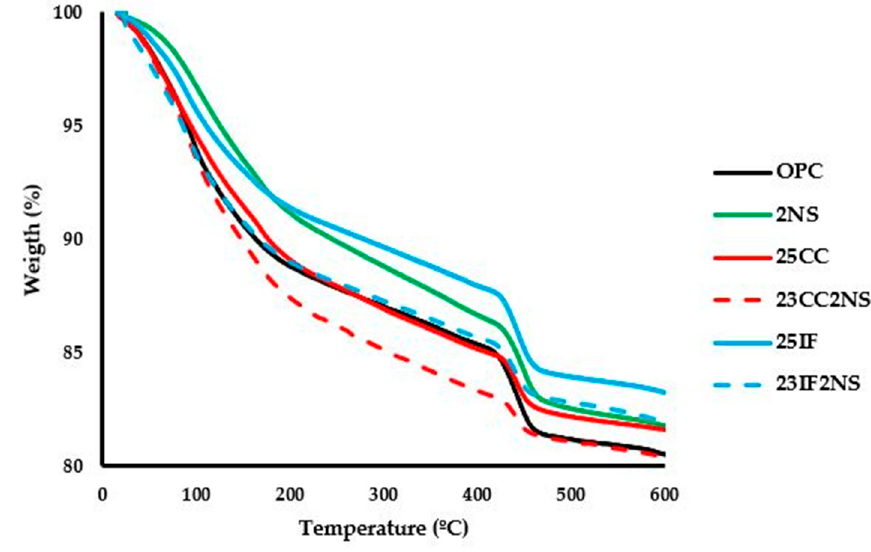
Figure 5. TGA curves, obtained for all pastes at 28 days of hydration.